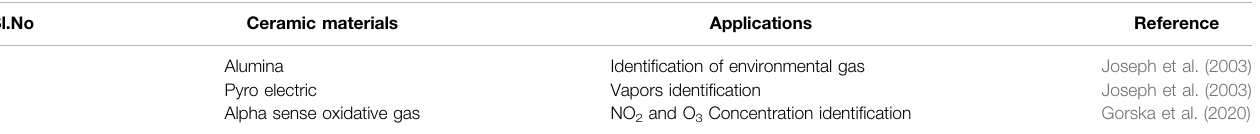
TABLE 1 | Examples of advanced ceramic materials and their various applications.